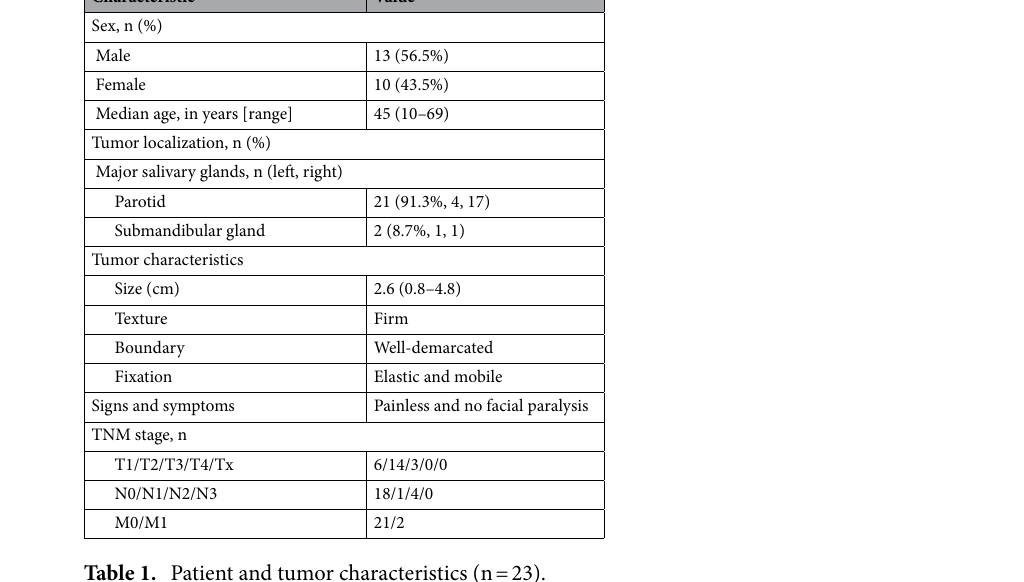
Table 1. Patient and tumor characteristics (n = 23).